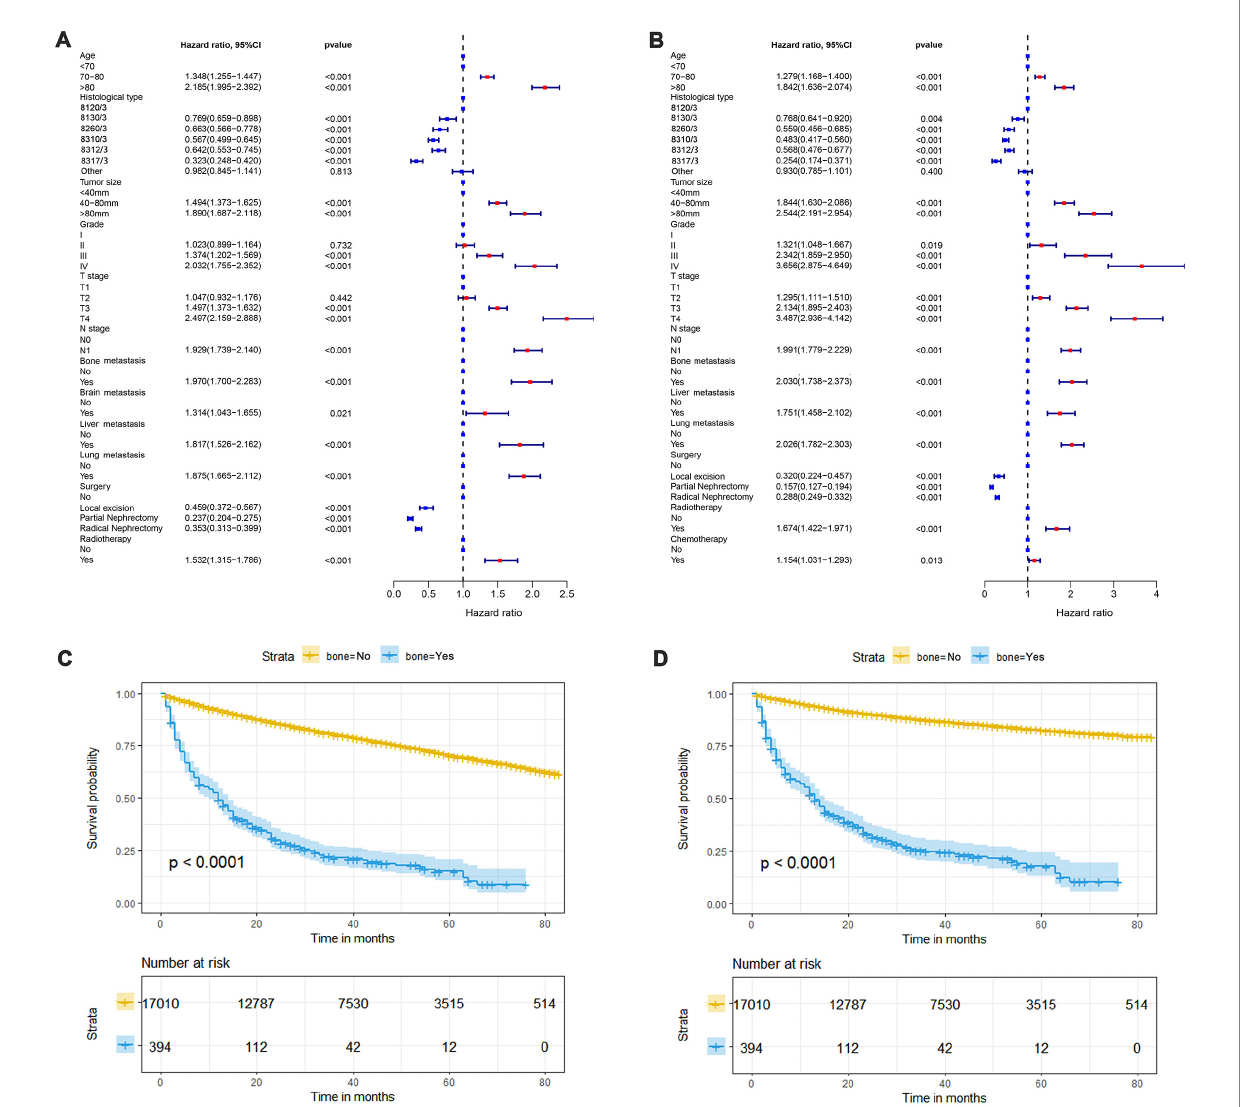
FIGURE 2 The forest plot shows the results of multivariate Cox regression analysis in which bone metastasis (BM) was significantly associated with overall survival (OS) and cancer-specific survival (CSS) in elderly KC patients (A,B) . Kaplan–Meier survival analysis was performed to investigate the effect of BM on OS and CSS in elderly KC patients (C,D)